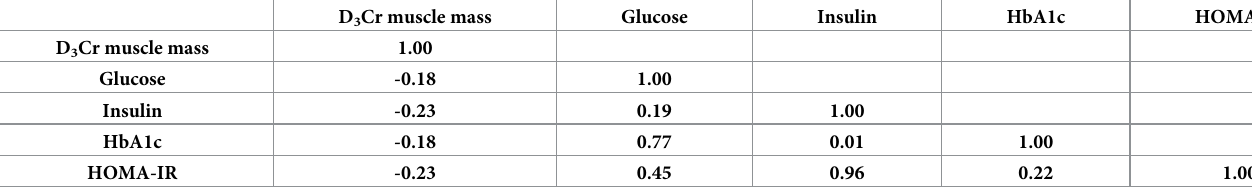
Table 3. Correlation matrix for D3Cr muscle mass and indices of insulin-glucose homeostasis.